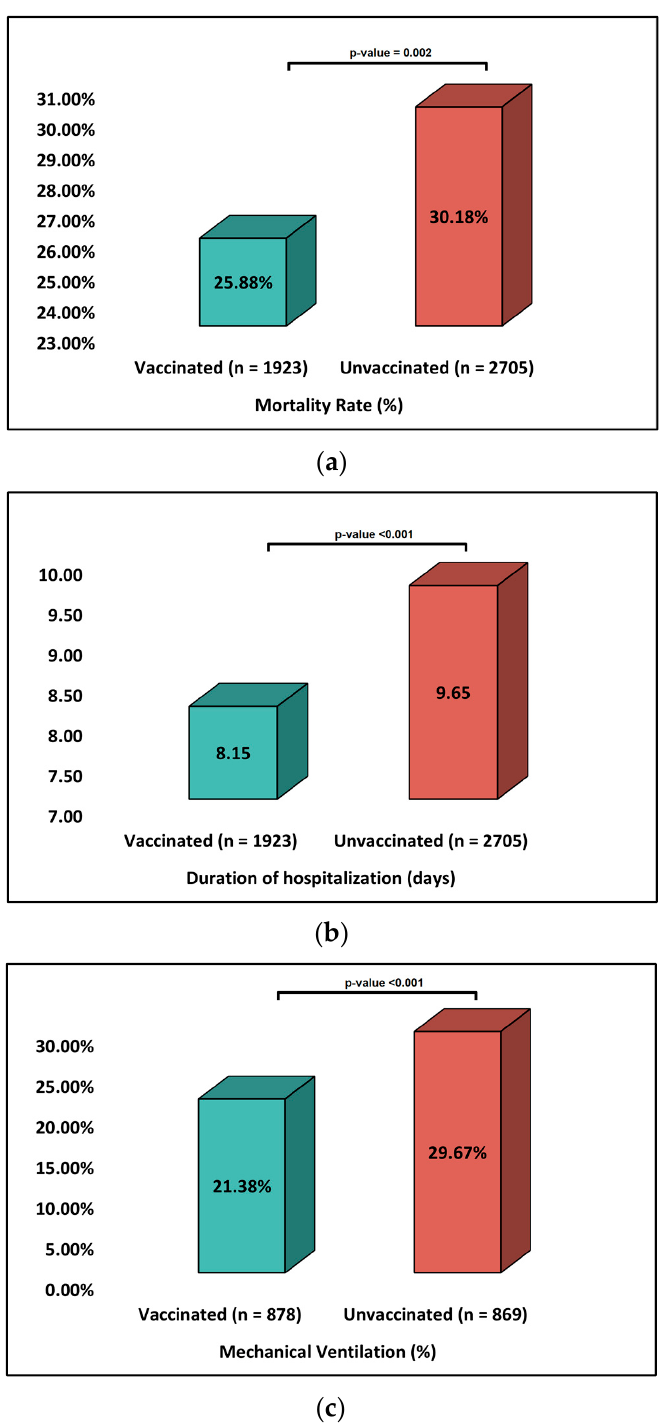
Figure 2. Summary of findings (vaccinated vs. unvaccinated patients); ( a )—Duration of hospitalization; ( b )—Mechanical ventilation; ( c )—Mortality Rate.